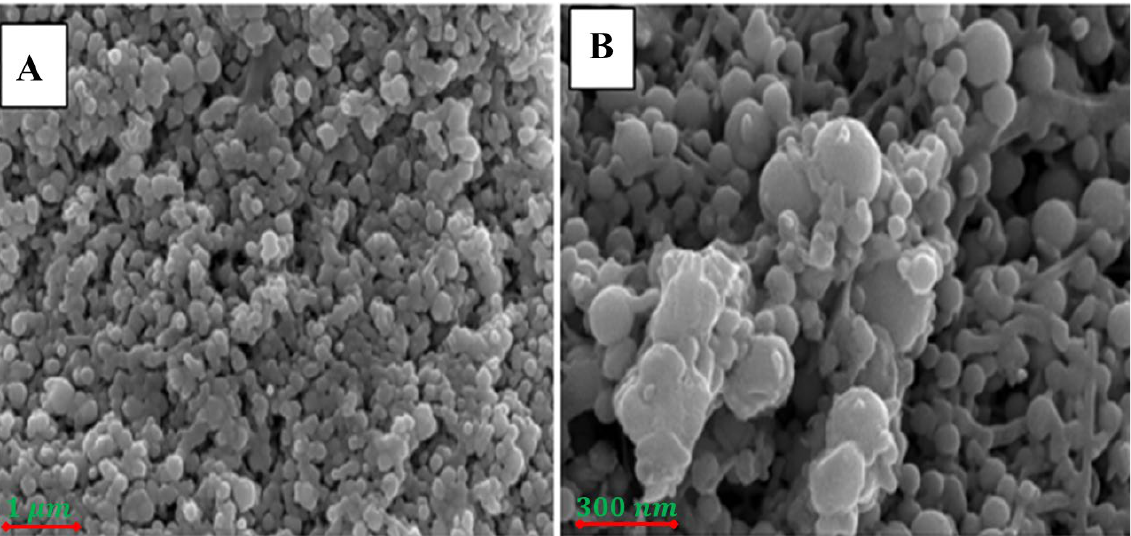
Figure 3. FE-SEM images of Se NPs synthesized at ( A ) 1 µm and ( B ) 300 nm using Withania Somnifera extract.